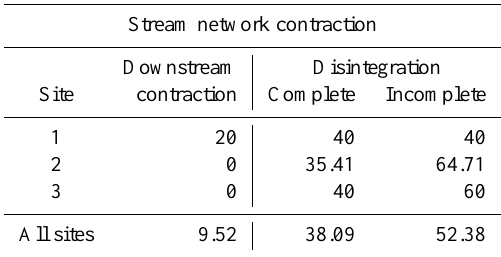
Table 5. Occurrence of each model of contraction as a percent of all